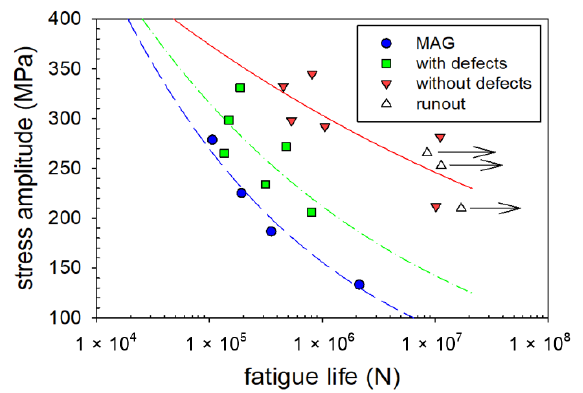
Figure 9. Wöhler curves of laser welded samples with and without internal defects compared with manual arc welding (MAG).